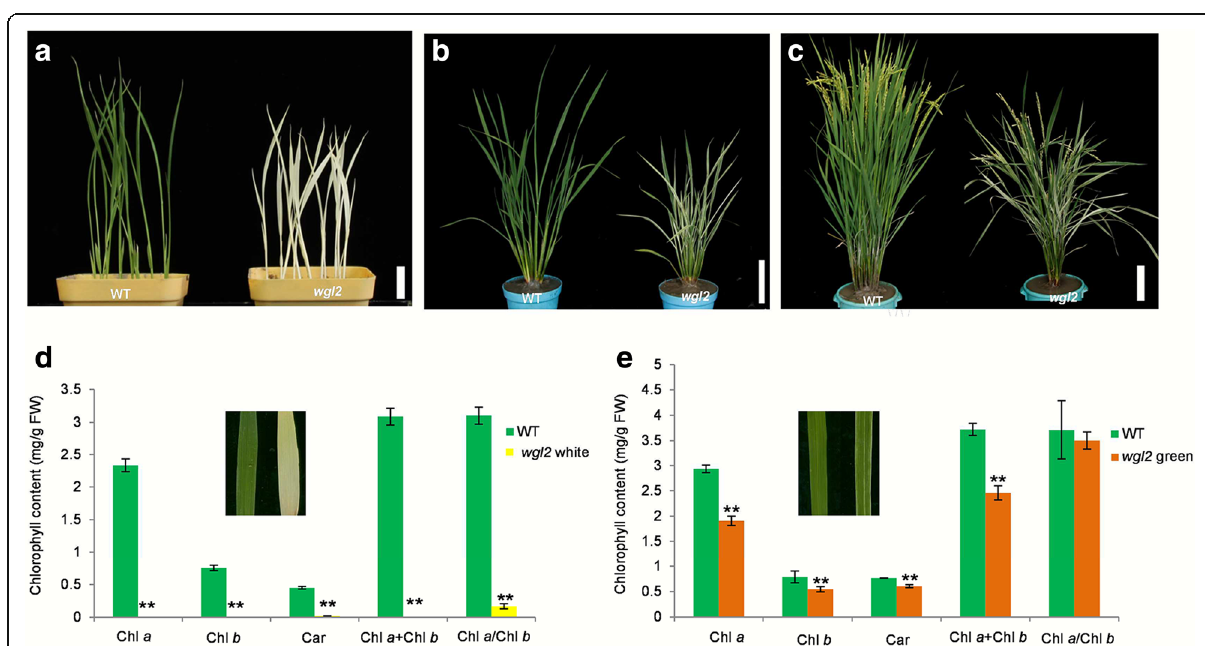
Fig. 1 Phenotypes and pigment contents of wild type and wgl2 plants. a - c Morphology of wild type (WT) and wgl2 plants at the seedling (bar=2 cm), tillering, and heading stages, respectively, in the paddy field (bar=10 cm). d Pigment contents of WT and wgl2 white seedlings. e Pigment contents of WT and wgl2 green plants that older than the white ones. Chl a , chlorophyll a ; Chl b , chlorophyll b ; Car, carotenoids. Values represent the mean±SD of